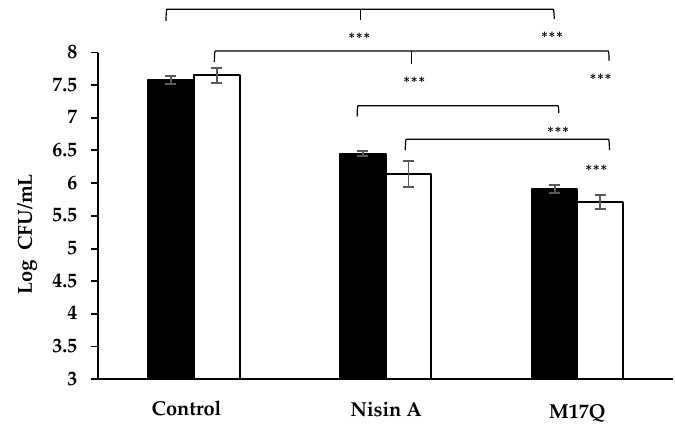
Figure 6. Kill curve performed in a simulated wound fluid where S. epidermidis 28 ( ) and S.